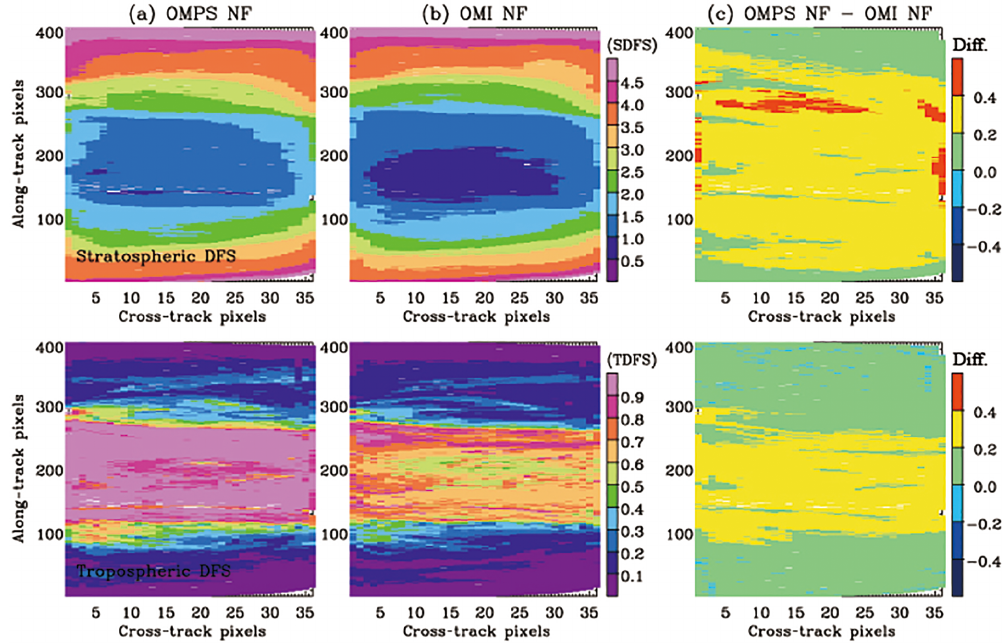
Figure 14. Same as Fig. 13 but for the integrated degrees of freedom for signal (DFS) in the stratosphere (top) and troposphere (bottom).